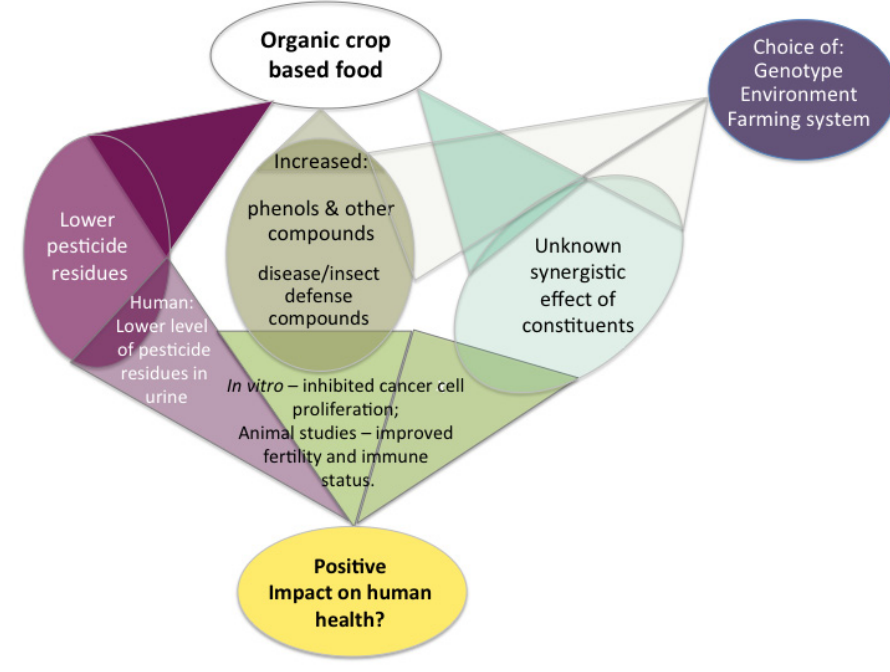
Figure 1. Interactive model showing proof of concept for interaction of different factors resulting in a possible positive impact on human health by organic crop based